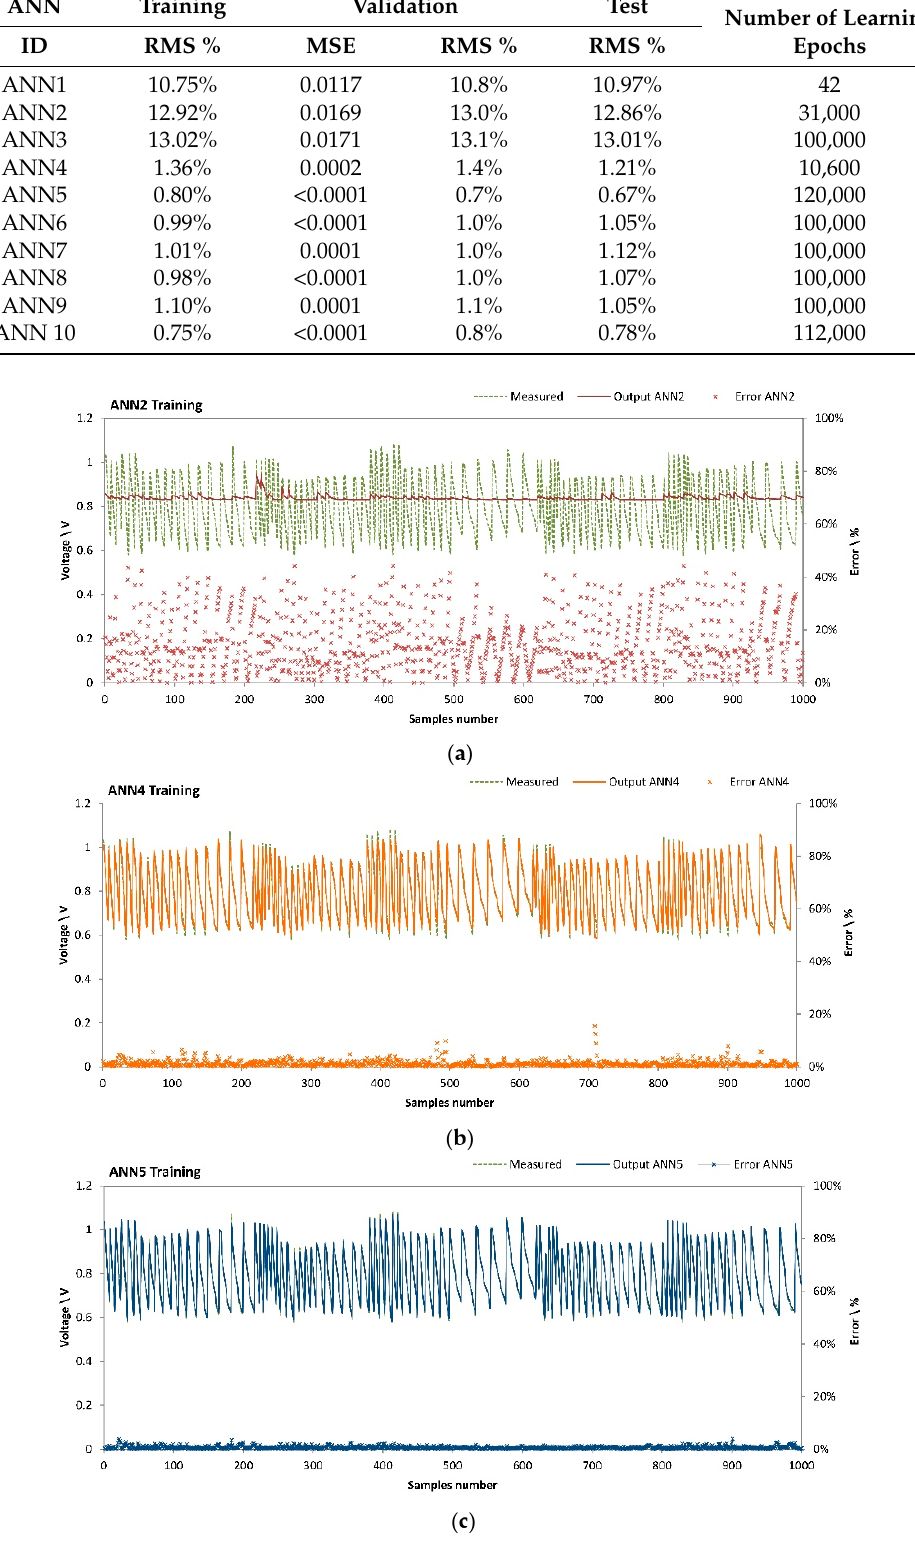
Figure 3. Training of ANN2 ( a ), ANN4 ( b ) and ANN5 ( c ): error dispersion.